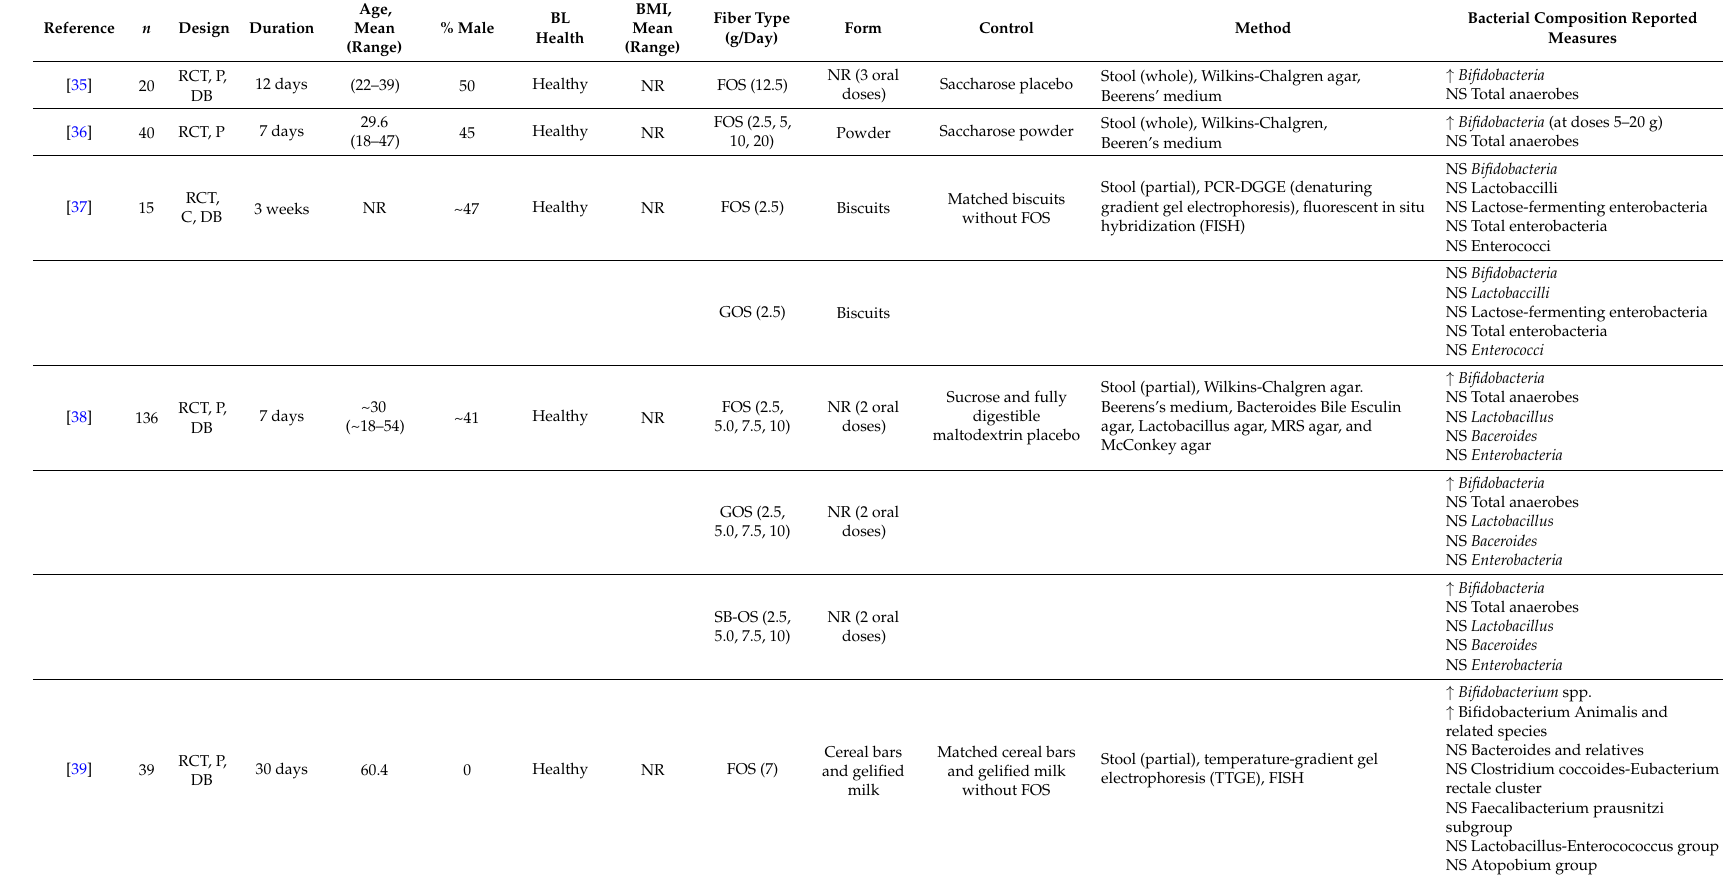
Table 4. Characteristics of oligosaccharide interventions and direction of evidence on bacteria